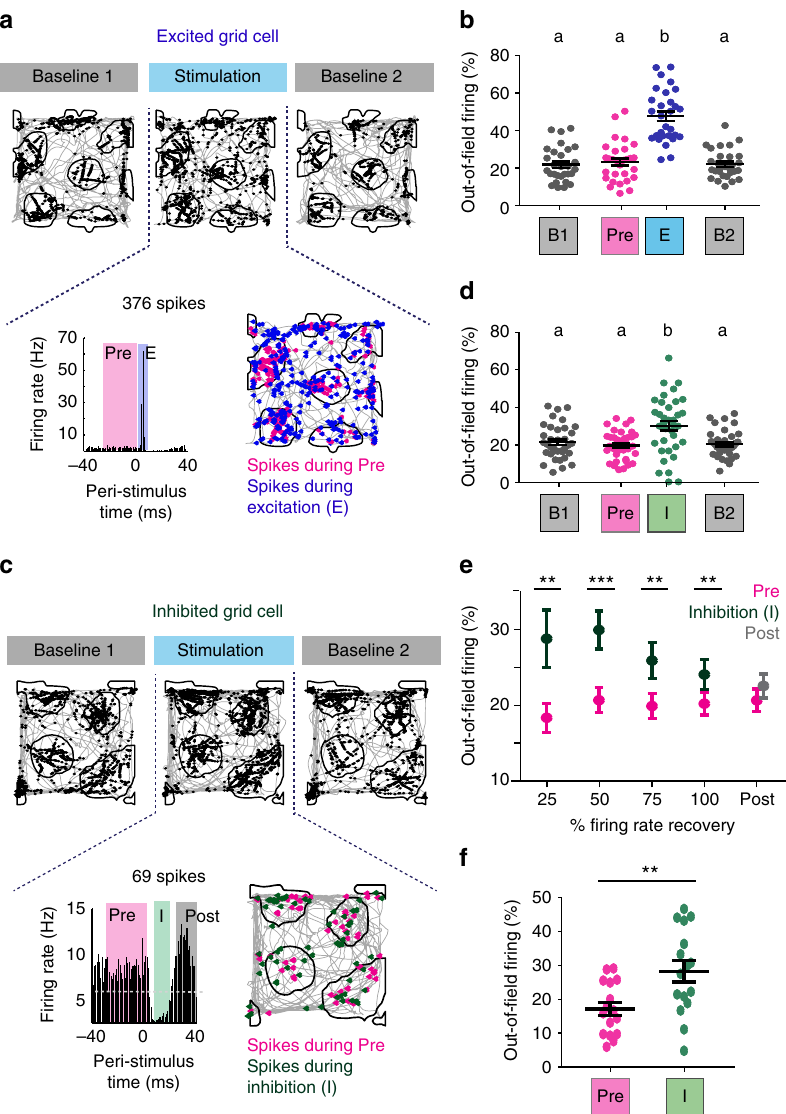
Fig. 8 Transient inhibition of mEC super fi cial layers decreased grid accuracy. a Example grid cell excited by the stimulation. The 376 spikes fi ring within 10 ms after light onset (E, blue in PSTH) were dispersed in space, while an equal number of randomly selected spikes from before light onset were predominantly located within grid fi elds (Pre, magenta in PSTH). b Increased out-of- fi eld fi ring of all excited grid cells con fi rmed the reduced accuracy of ChR2 evoked spikes [one-way repeated-measures ANOVA, n = 29 cells from 3 mice, F (2.344,65.62) = 51.84, p < 0.0001]. Signi fi cantly different groups (Tukey ’ s multiple comparisons test, p < 0.05) are assigned different letters (a, b). c Example grid cell inhibited by the stimulation. The 69 spikes during inhibition (I, green in PSTH) were less accurate than an equal number of randomly selected spikes from before light onset (Pre, magenta in PSTH). d Increased out-of- fi eld fi ring during maximal feedback inhibition [one-way repeated-measures ANOVA, n = 36 cells from 3 mice, F (1.721,60.23) = 10.03, p = 0.0003] indicates reduced grid accuracy. Signi fi cantly different groups (Tukey ’ s multiple comparisons test, p < 0.05) are assigned different letters (a, b). e The percentage of spikes outside of grid fi eld boundaries during different inhibition windows (up to 25, 50, 75, and 100% of recovery to baseline rate; I, green) compared to an equal number of spikes from Pre (magenta). Grid fi ring was restored after cells recovered from inhibition [Post, gray